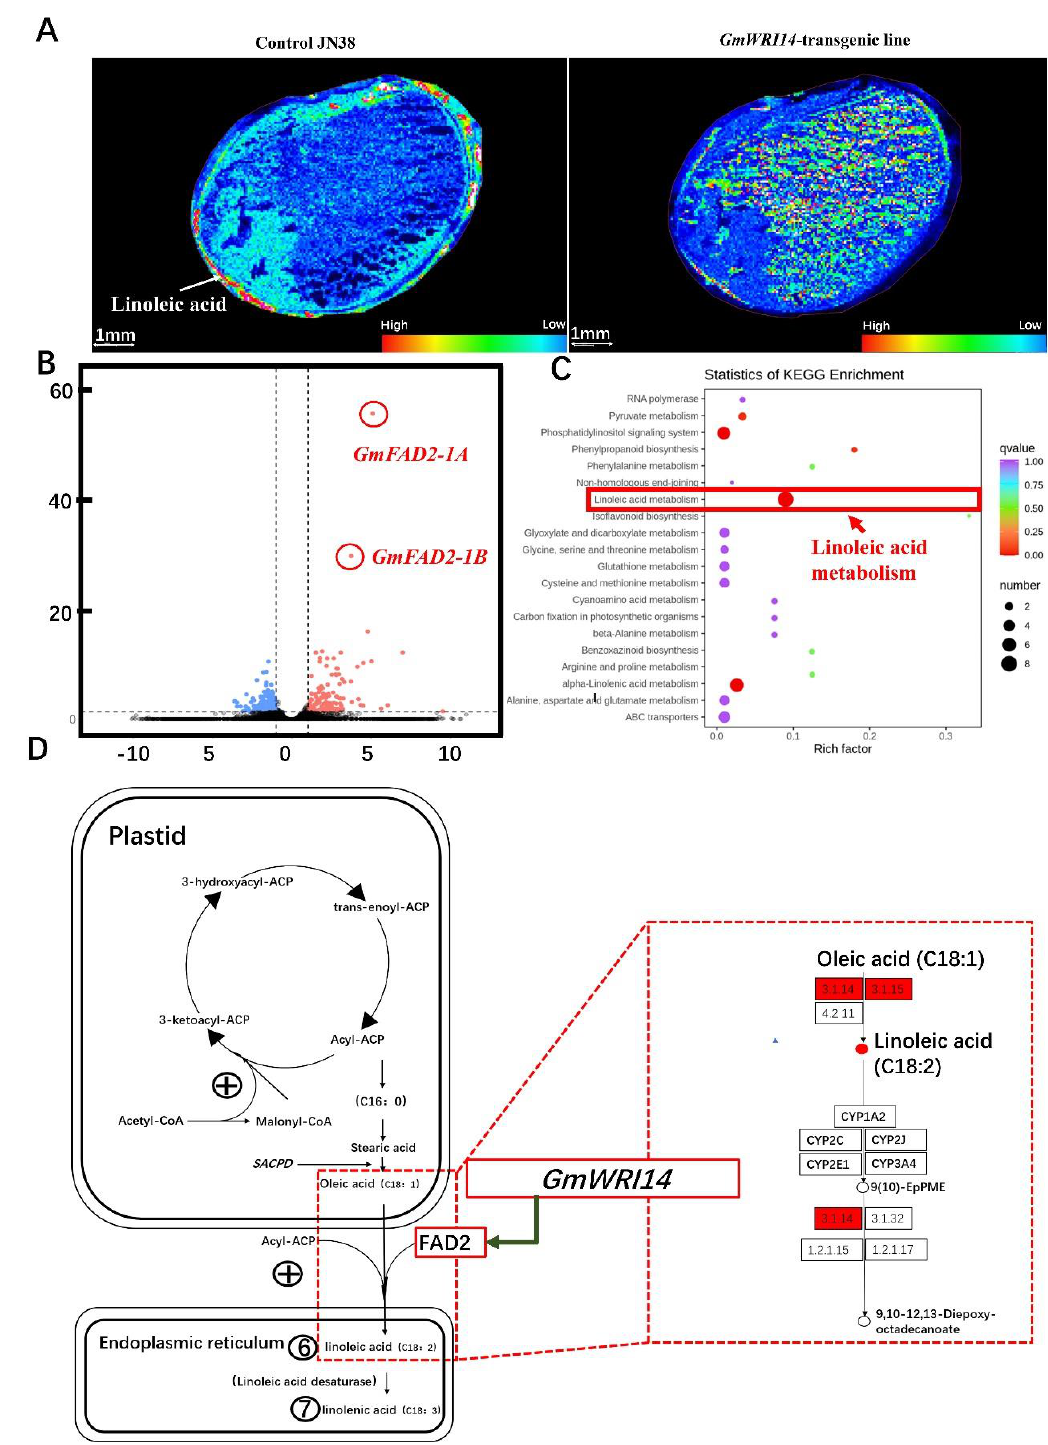
Figure 3. DEGs related to LA in GmWRI14 transgenic soybean plants. ( A ) Analysis of the LA distribution in soybean seed using MALDI-TOF-MS. The red region represents LA. Scale bar, 100 mm. ( B ) DEGs were screened by transcriptomics. The red dot represents the up-regulated genes, while the blue dot represents the down-regulated differential genes. ( C ) Functional characterization of GmWRI14 transgenic soybean for a KEGG enrichment analysis. ( D ) DEGs of a KEGG pathway map. For the GmWRI14 transgenic soybean, the enzyme labeled with a red box was related to the down- regulated gene. The number in the box represents the fatty acid dehydrogenase (enzyme number), which explains the origin of phenotypic differences through the pathway.